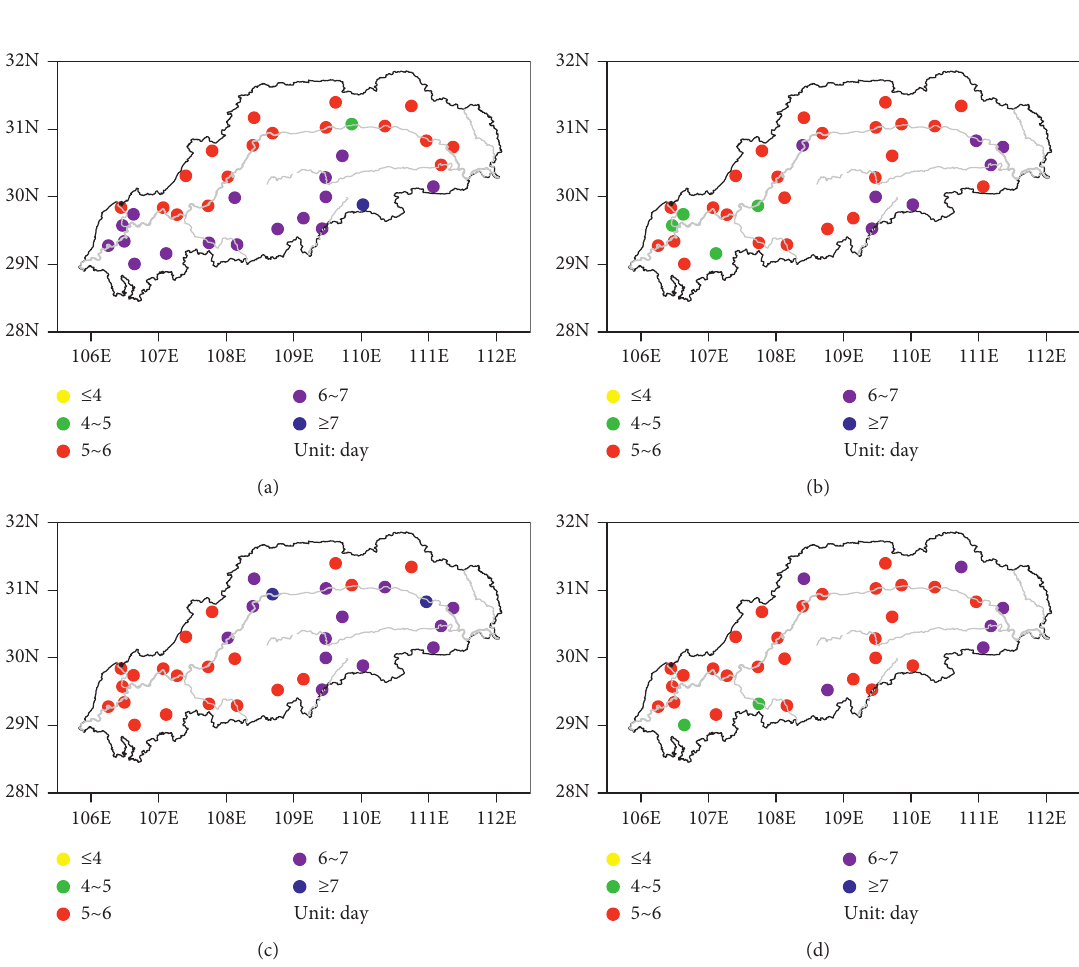
Figure 22: The spatial distribution of CWD calculated from (a) gauge observation, (b) TRMM, (c) CMORPH, and (d) PERSIANN at each rain-gauge